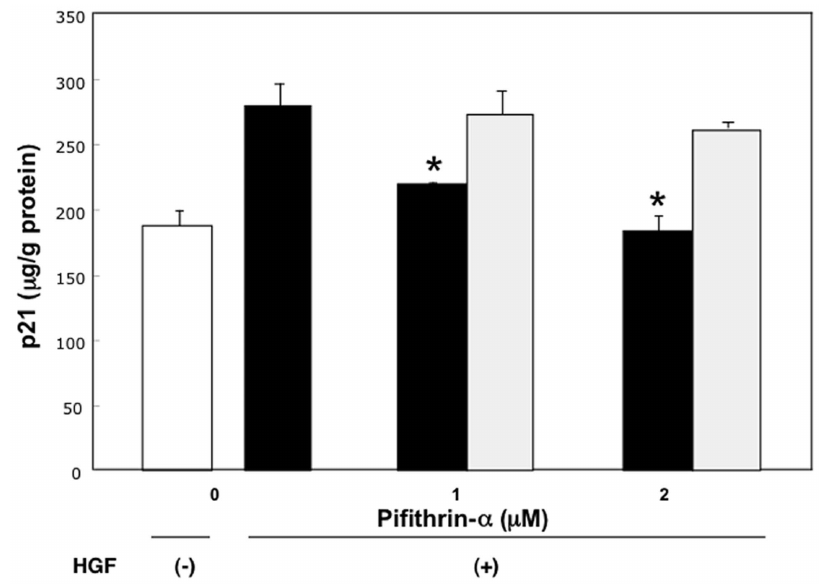
Figure 6. The effect of pifithrin- a on p21 levels of hepatocytes in the presence of HGF. Rat hepatocytes were cultured at high density in WE containing 10% FCS, 10 ng/mL HGF, along with various concentrations of pifithrin- a , the chemical inhibitor of p53, dissolved in DMSO, or DMSO of the same concentration for 18 hours. An open bar denotes hepatocytes cultured in the absence of HGF. Closed bars denote hepatocytes cultured with pifithrin- a in the presence of 10 ng/mL HGF. Dotted bars denote hepatocytes cultured with DMSO in the presence of 10 ng/mL HGF. Data are mean 6 SEM of four dishes. *p , 0.05 compared with the values treated only with HGF or values treated with HGF and DMSO.